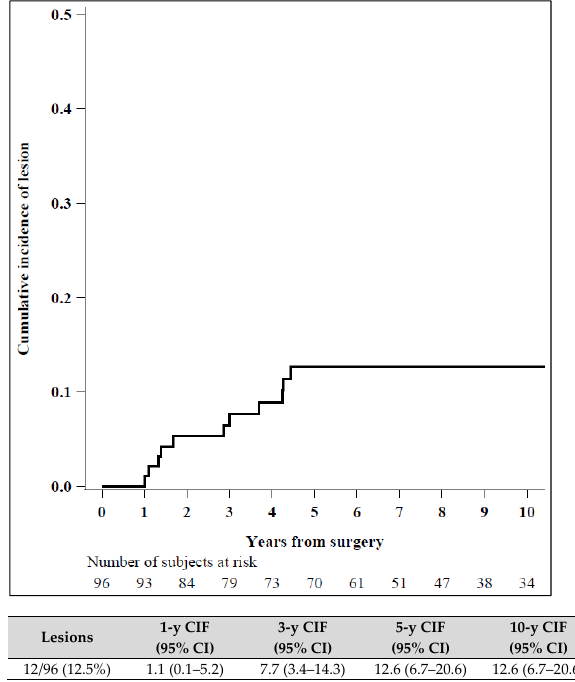
Figure 2. Cumulative incidence of lesion (N = 96).